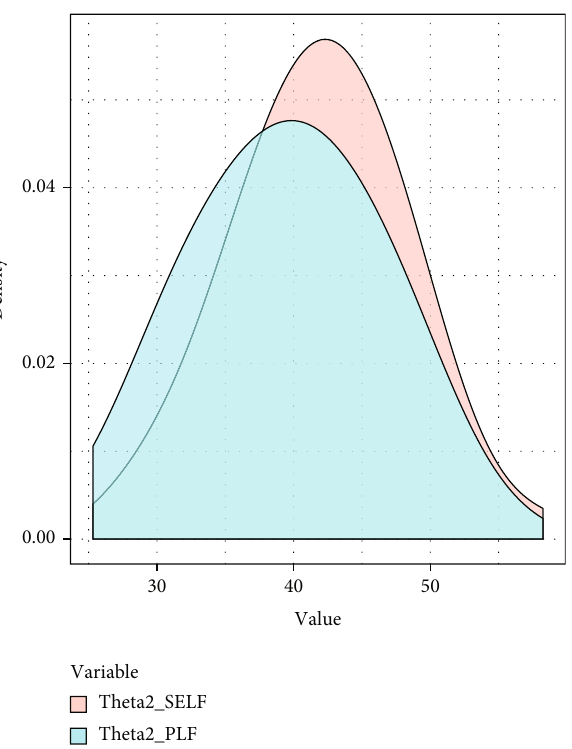
Figure 2: The marginal density for θ